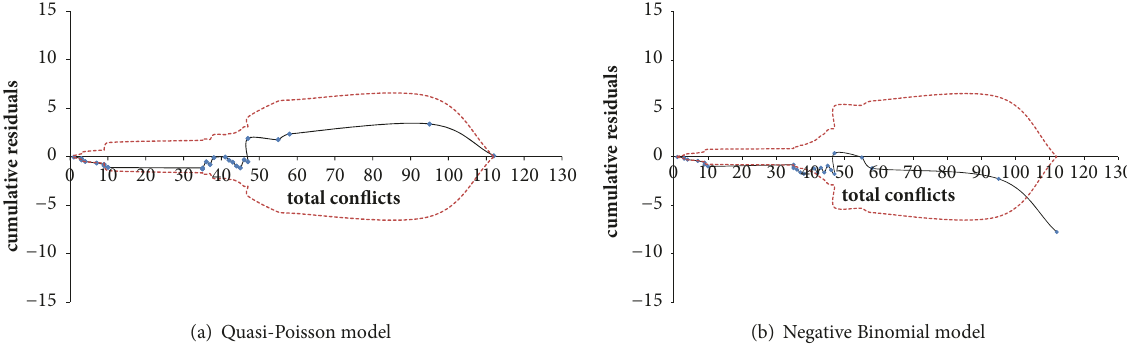
Figure 5: CURE plots for total conflicts: (a) quasi-Poisson model; (b) Negative Binomial